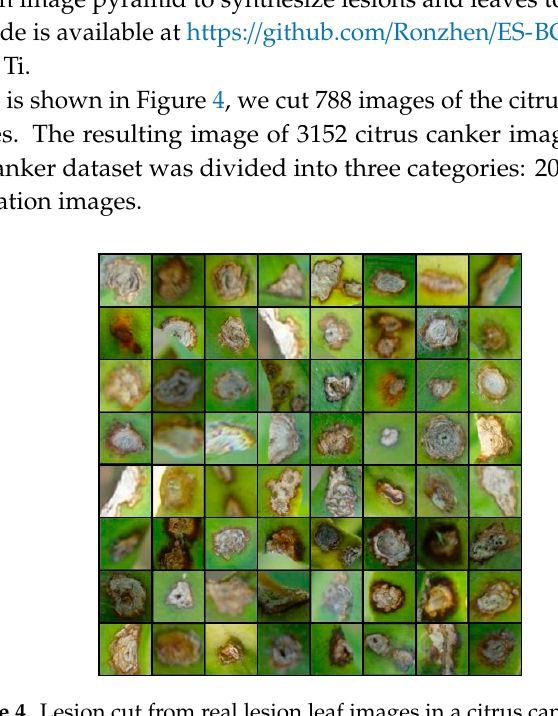
Figure 4. Lesion cut from real lesion leaf images in a citrus canker dataset.